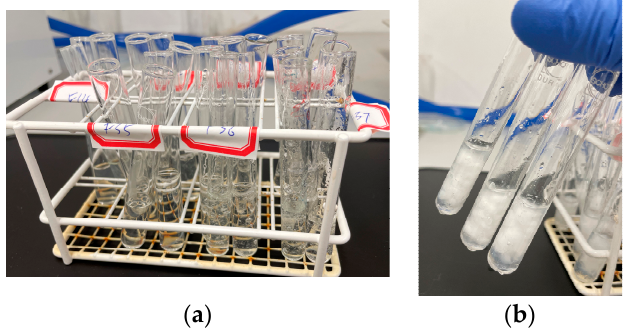
Figure 3. Cloud-point measurements of the aqueous solutions: ( a ) Transparent aqueous solutions at room temperature. ( b ) Upon heating, the aqueous solutions became turbid. Table 2. Comparison table illustrating the LCST values obtained from cloud-point analysis and UV spectroscopy.